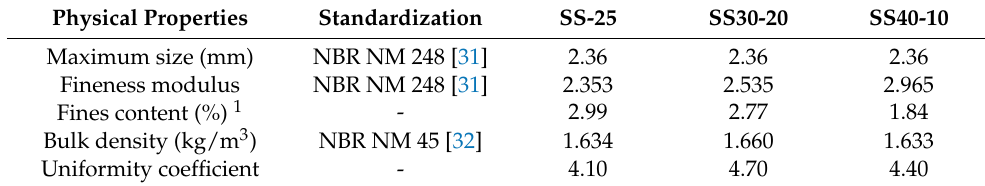
Table 2. Physical properties of